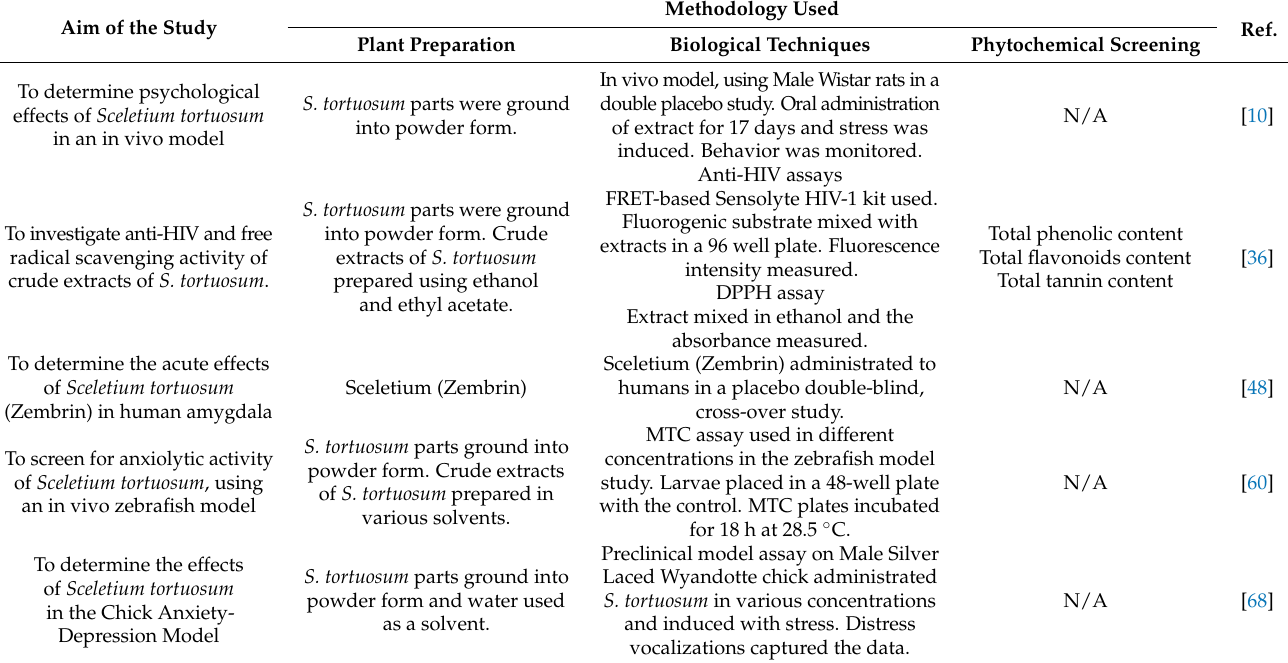
Table 2. Methodology of biological properties of Sceletium